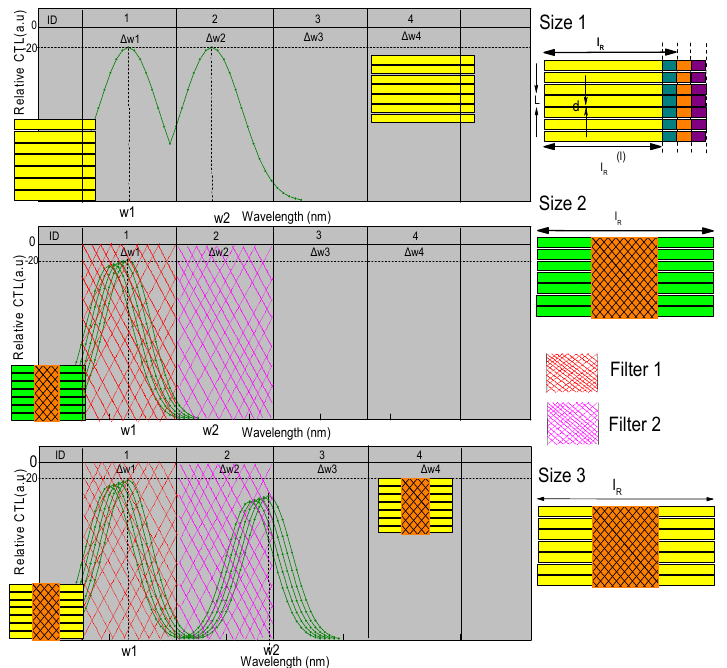
Figure 7. Different CTL signal spectra separated by multiple wavelength channels.